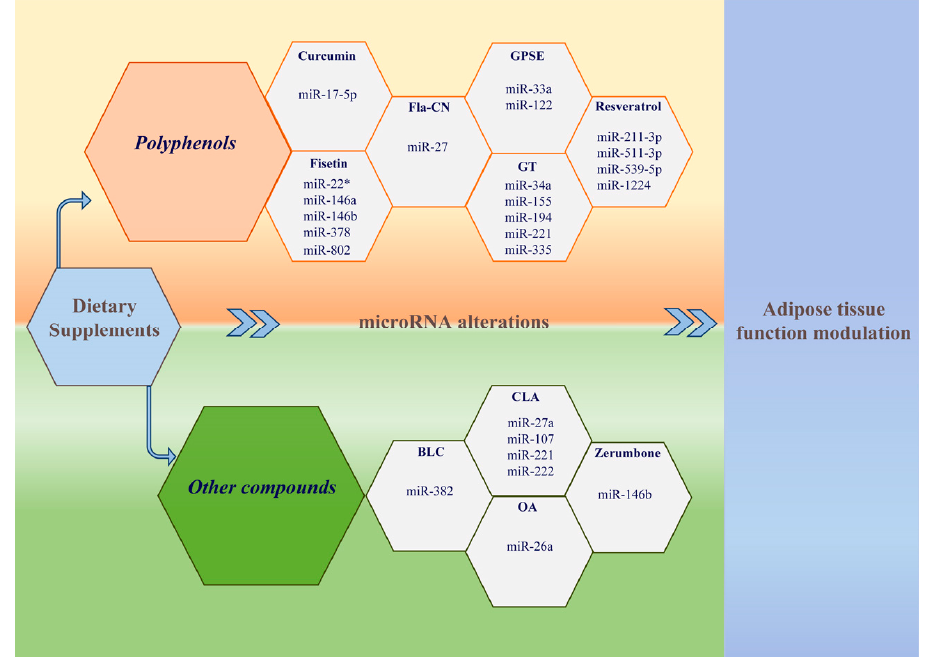
Figure 1. Dietary supplements modify microRNA expression modulating adipose tissue function.